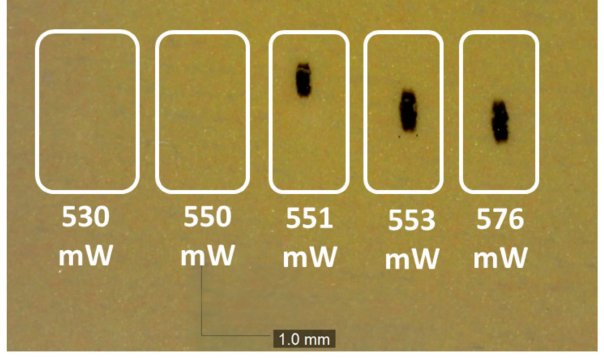
Figure 8. Phosphor catastrophic degradation as a function of incident power.